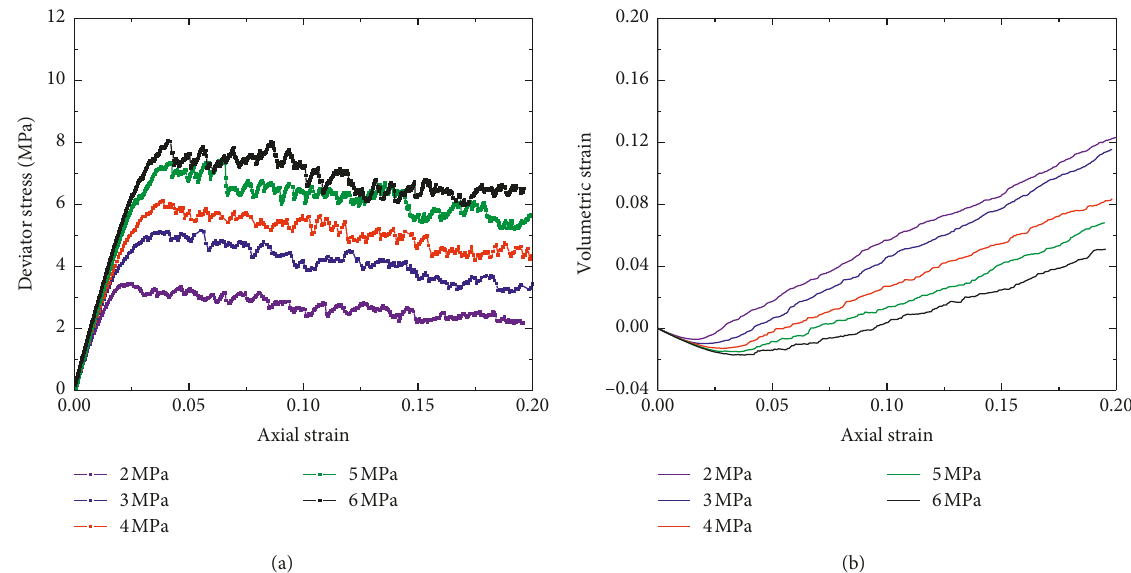
Figure 7: Simulation results of breakable samples subjected to biaxial compression: (a) deviator stress against axial strain; (b) volumetric strain against axial strain.